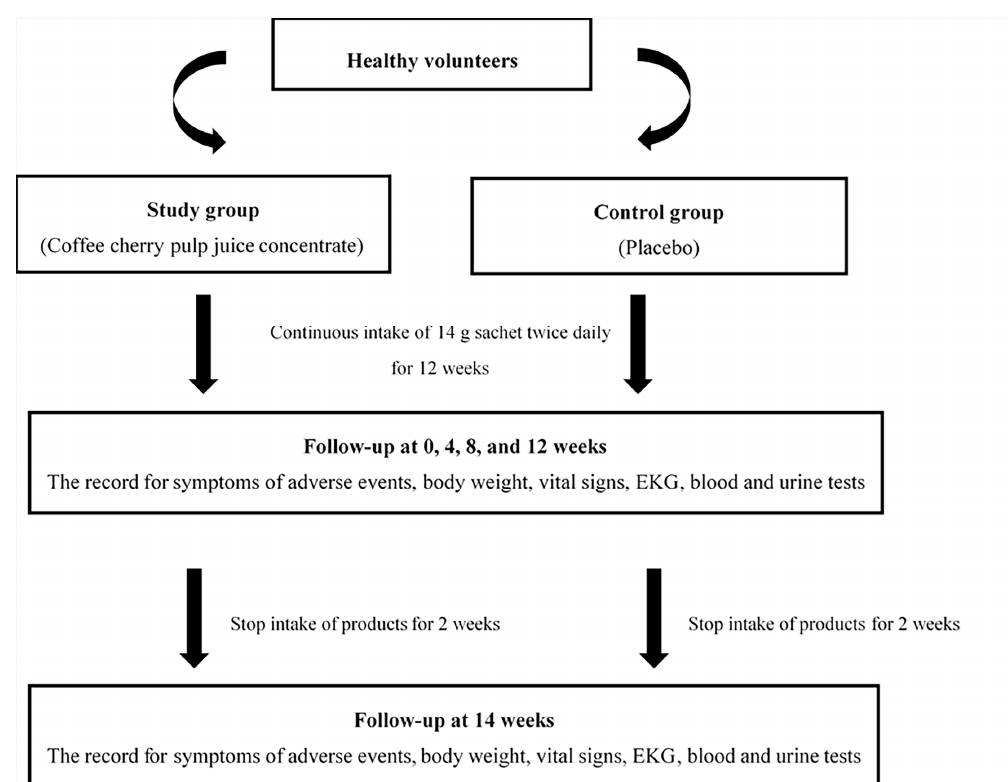
Figure 1. Conceptual framework.